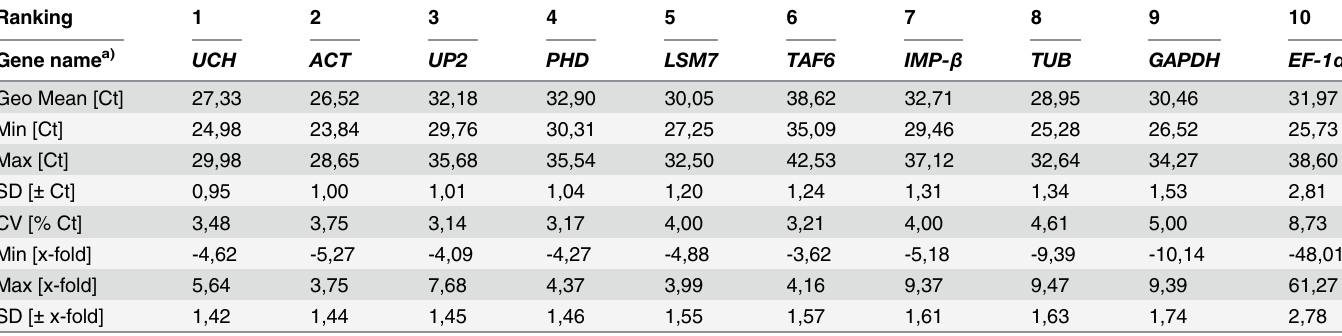
Table 3. Descriptive statistics of six newly identified and four classical pepper reference genes based on their crossing point values in all samples combined (n = 48) as calculated by